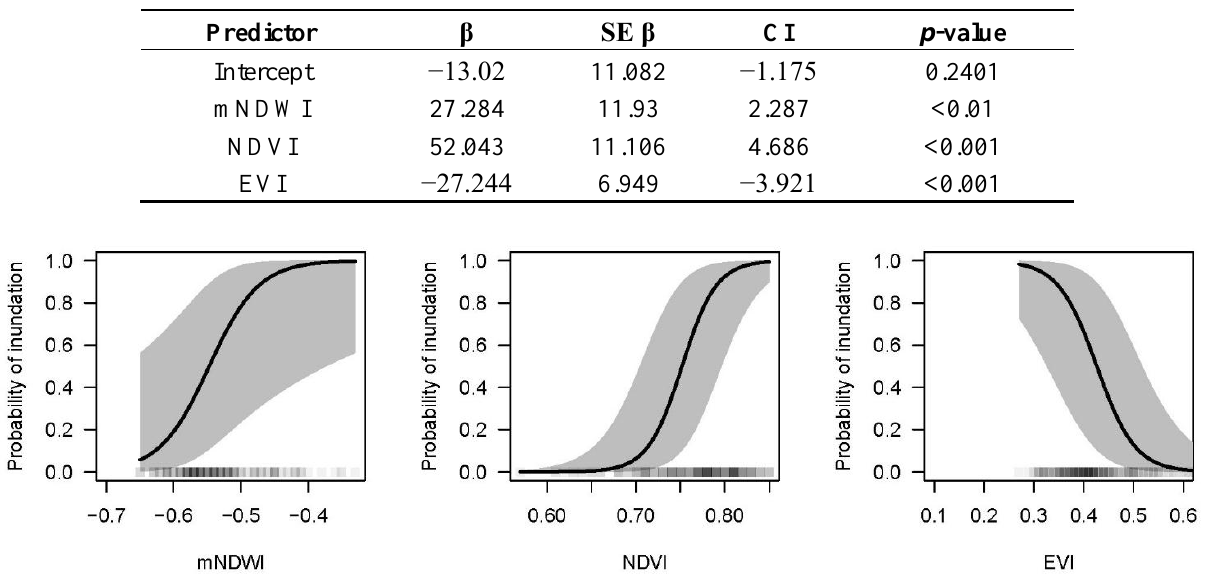
Table 3. Generalized Linear Mixed Model (GLMM) results (β = regression parameter, SE β = standard error of β, CI = confidential interval, p -value) for all model predictors (mNDWI, NDVI, EVI from MODIS).